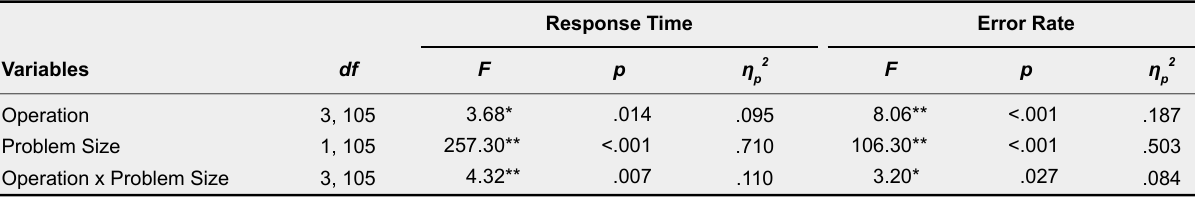
Statistical Analyses of Response Time and Error